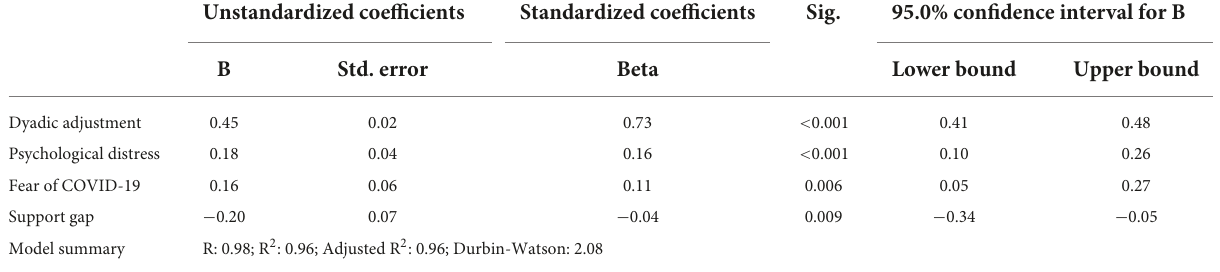
TABLE 2 Results of multivariable logistic regression analysis considering communal coping as a dependent